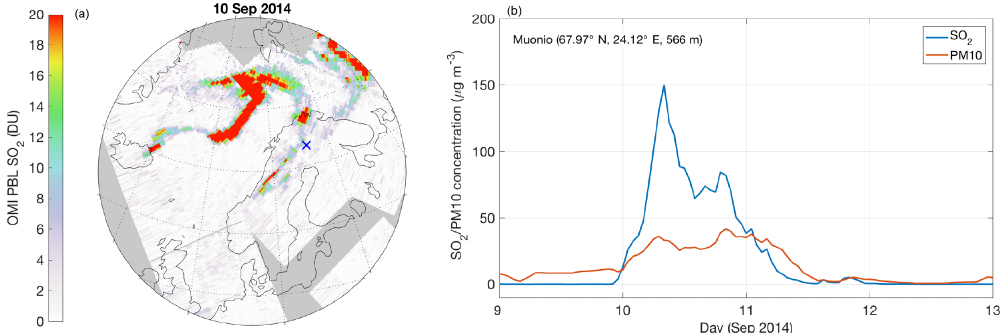
Figure 7. (a) Detection of SO 2 emissions from the Holuhraun (Iceland) eruption by the OMI very fast delivery (VFD) system on 10 September 2014. (b) Ground-based SO 2 measurements and breathable aerosols (PM 10 ) over Muonio measurement station (Finland; location indicated by a cross on the VFD image) from 9 September up until and 13 September